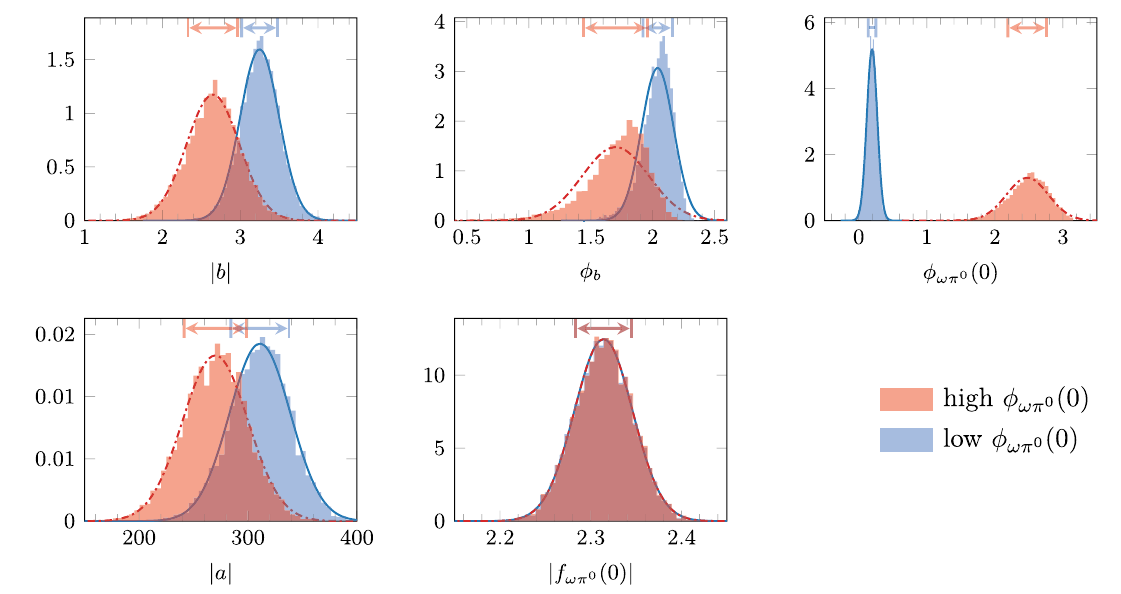
Fig. 12 One dimensional distributions of the free parameters in the Monte Carlo analysis performed, for the “3 par.” case fit. A Gaussian distribution with the average and error quoted in Table 2 is superim-